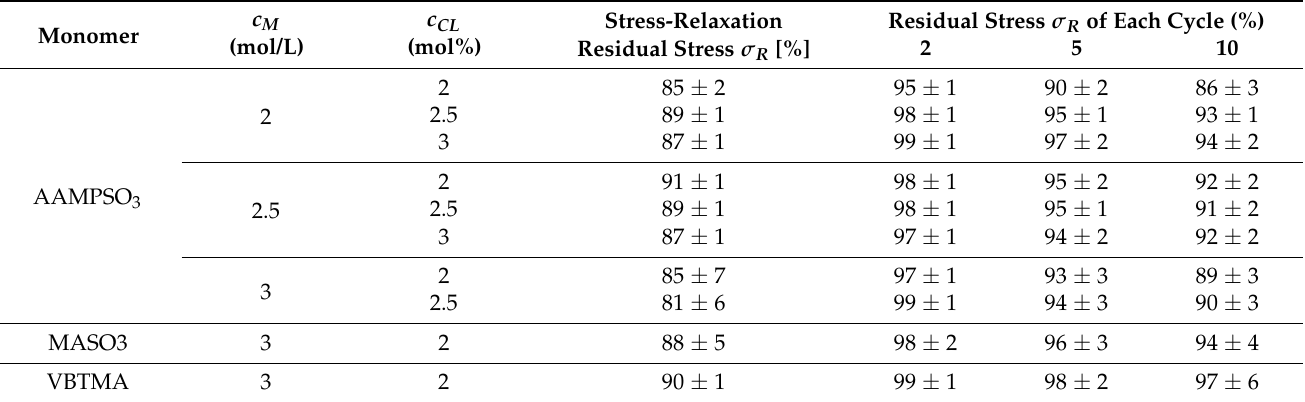
Table 4. Residual stress of the investigated hydrogels after different cycles of the cyclic compression loading experiments.